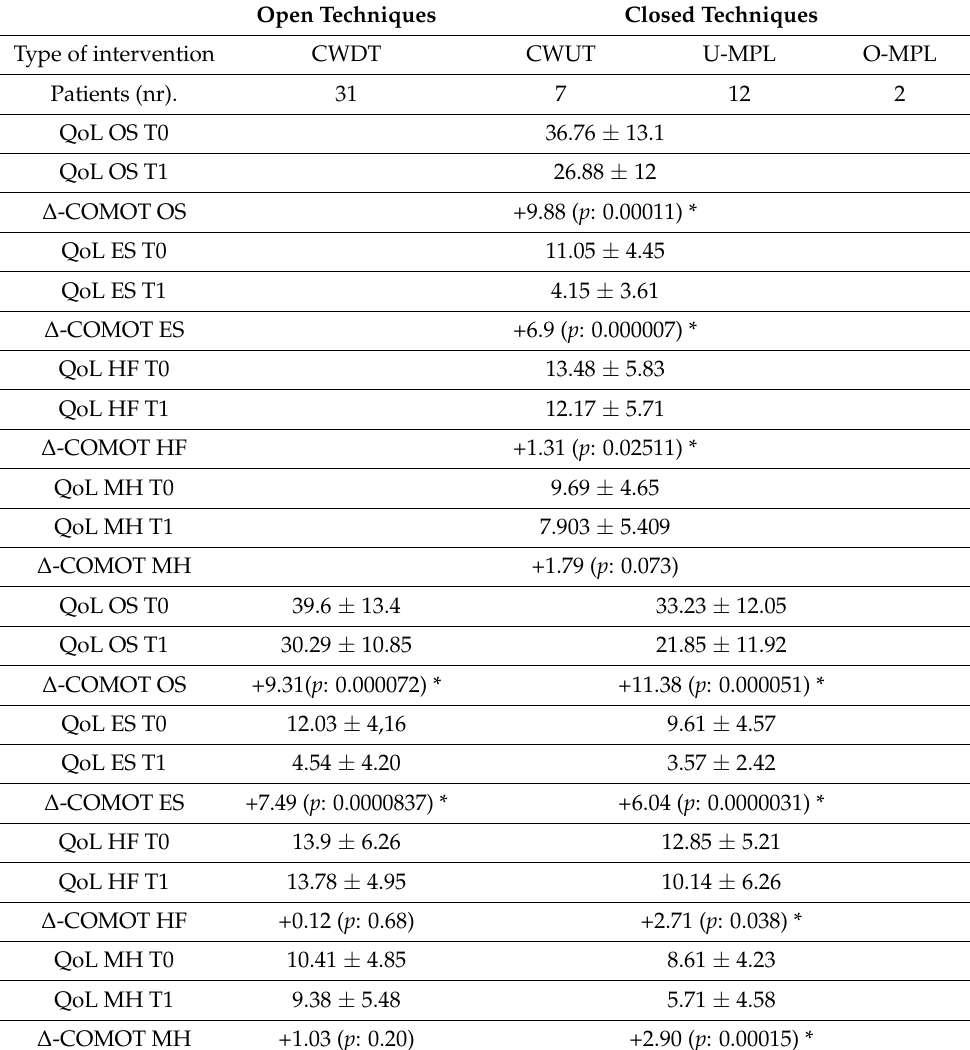
Table 2. The results of COMOT-15 and its subscales for the whole group and analyzed subgroups separately. Open Techniques Closed Techniques Type of intervention CWDT CWUT U-MPL O-MPL Patients (nr).